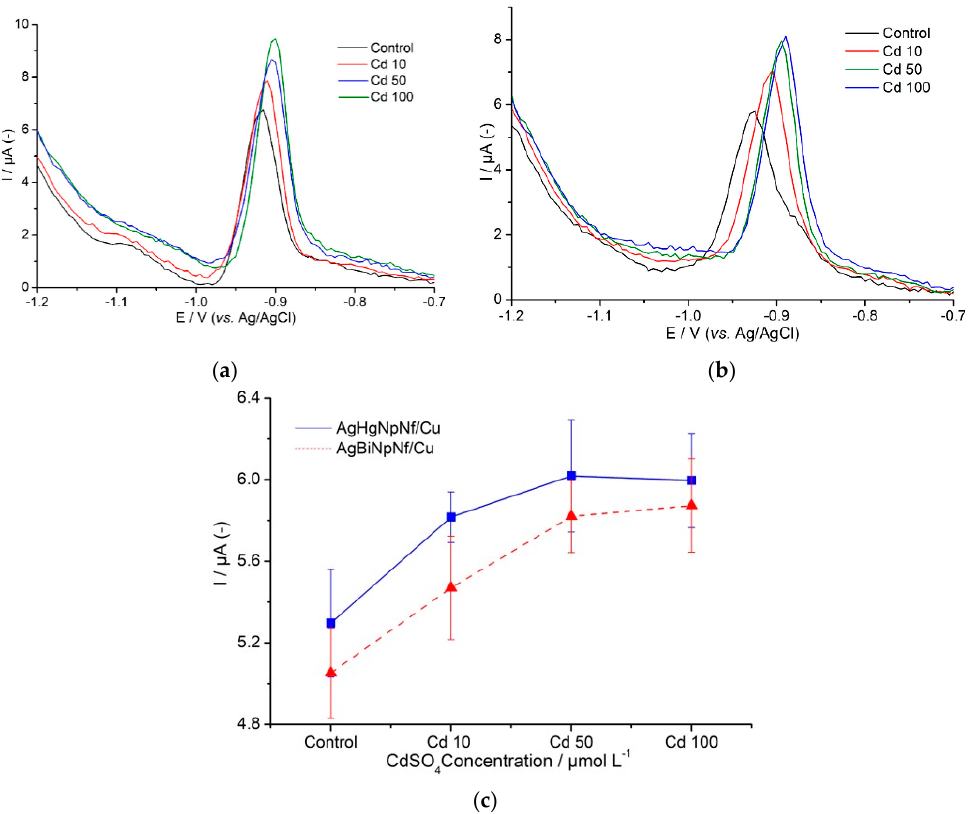
Figure 7. Differential pulse voltammetry signals obtained during the experiments: ( a ) AgHgNpNf/Cu electrode and ( b ) AgBiNpNf/Cu electrode. ( c ) Dependence of the HE current generated by nicotiana tabacum cells on increasing concentration of Cadmium sulfate in a Brdicka medium using the AgBiNf/Cu, and the AgHgNf/Cu electrodes in a Brdi č ka medium, after 5 days culturing.